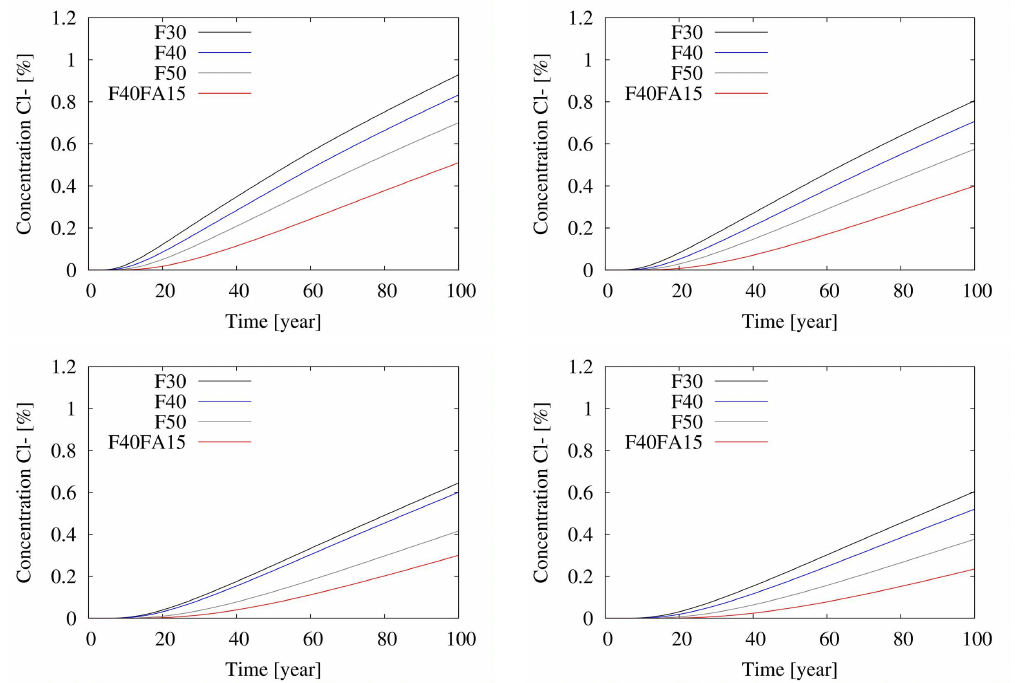
Fig. 10. Effects of aggregate volume fraction and of fly ash on the chloride diffusion in concrete at different position from the